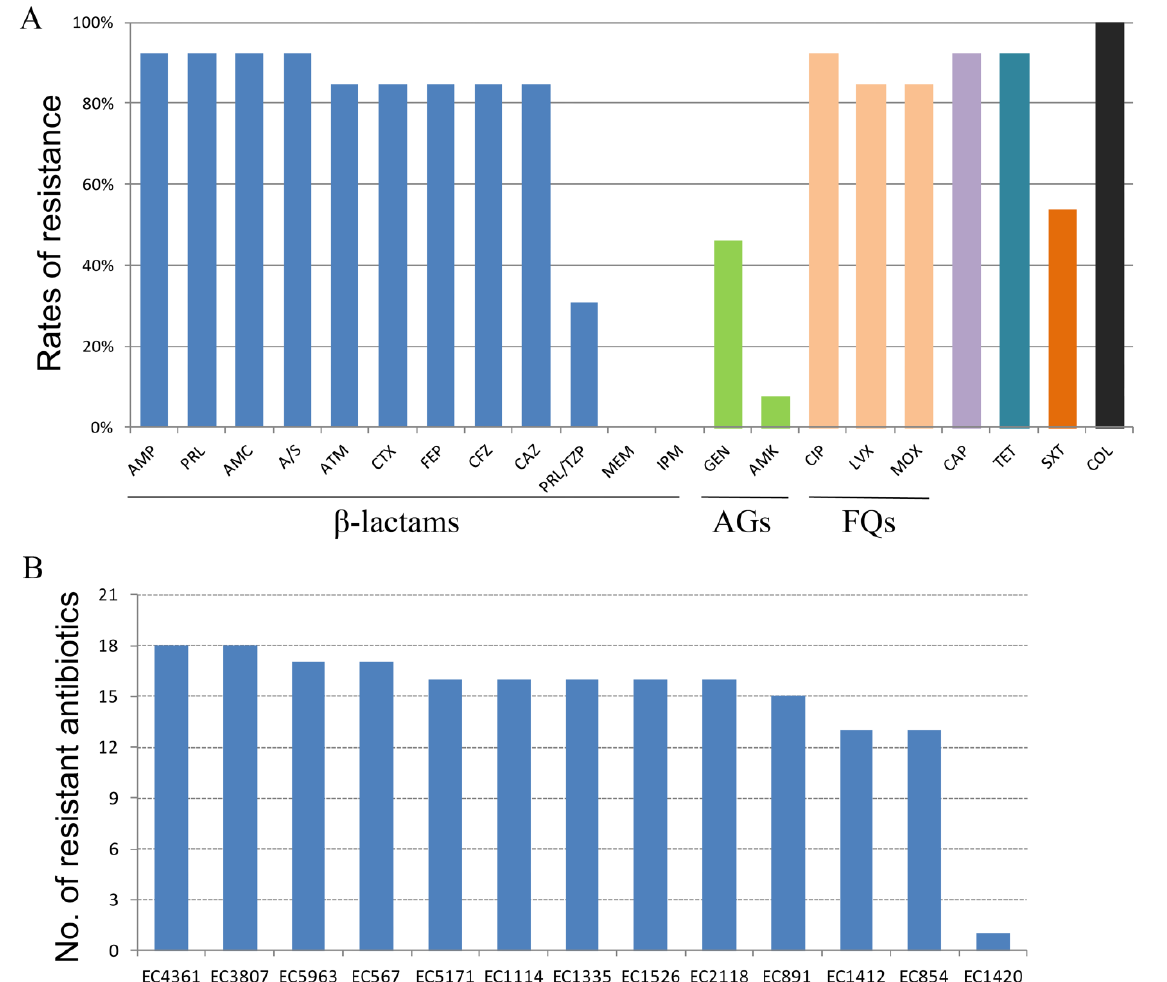
Figure 1. Antimicrobial susceptibility profiles of the 13 MCREC strains. ( A ) Resistance rates to 21 antimicrobial agents among the 13 MCREC strains. Each of the color represent one class of antibiotics; ( B ) The number of antibiotics that have been rendered ineffective for each MCREC strain. AGs, Aminoglycosides; FQs, Fluoroquinolones; AMP, ampicillin; PRL, piperacillin;